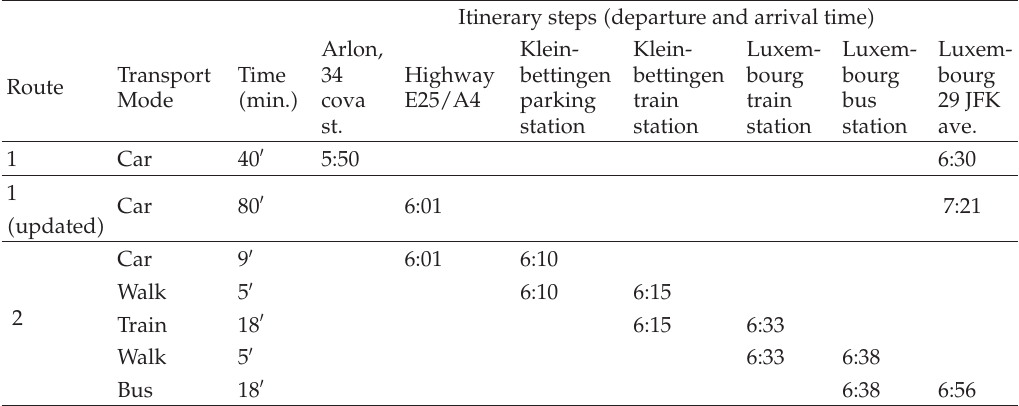
Table 4: Routes calculated for the validation